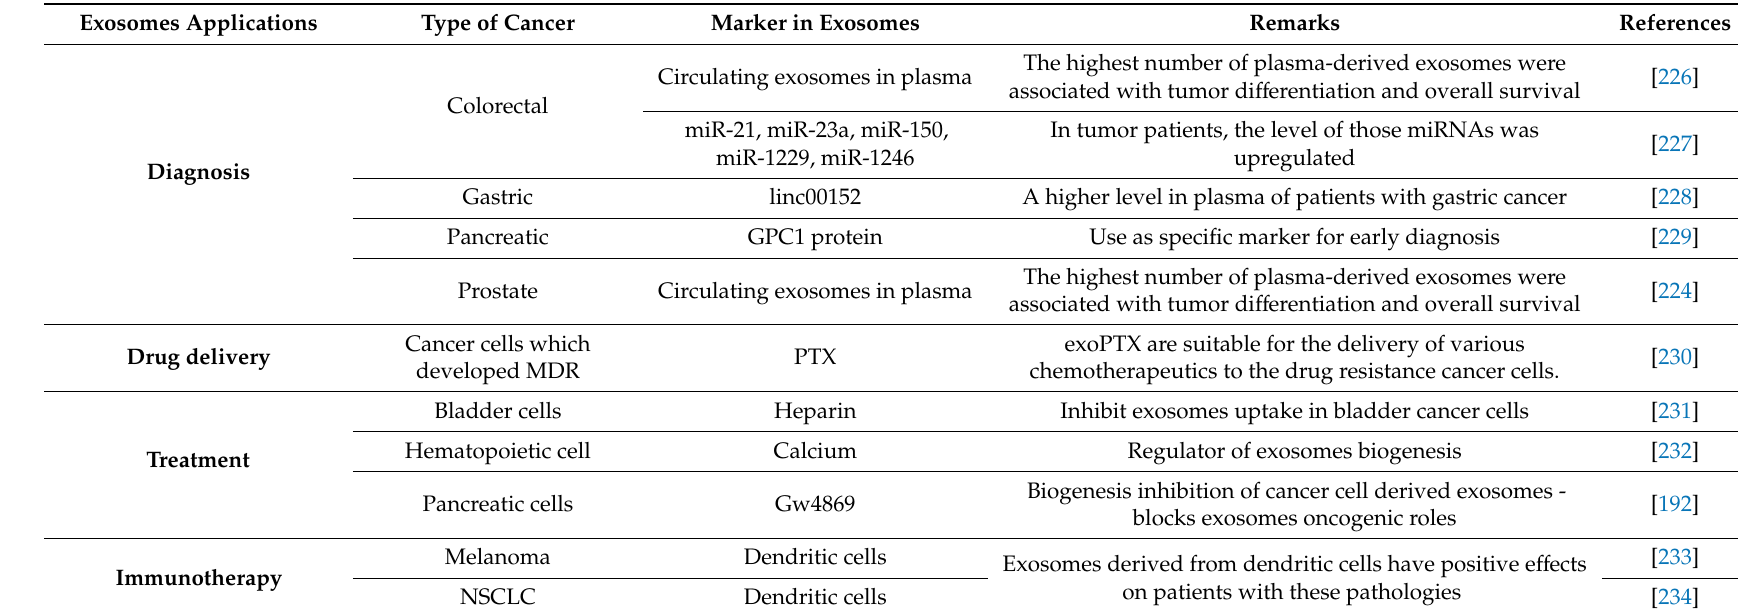
Table 2. Potential clinical applications for exosomes in various types of